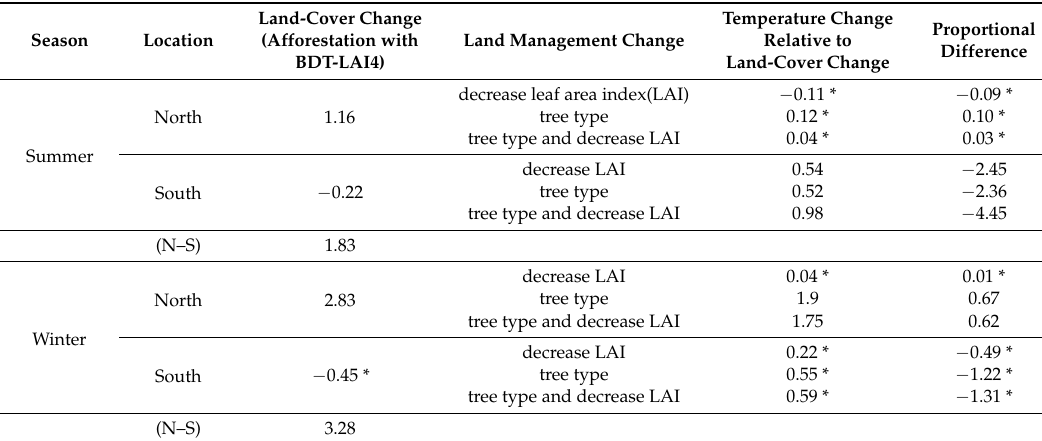
Figure 4. An analysis of the simulations in Figure 3 to compare the influence of land-cover change ( a , e : defined as afforestation from grass to broadleaf deciduous tree with an LAI of 4) to the influence of land management ( b – d , f – h : defined as change in tree type or a decrease in LAI from 4 to 2) on seasonal land surface temperatures. The stipples denote statistical significance between simulations at the p < 0.05 level. The horizontal line denotes the northern and southern extents used in the analysis. Table 2. The influence of land-cover and land management change on surface air temperatures. All values are in °C.